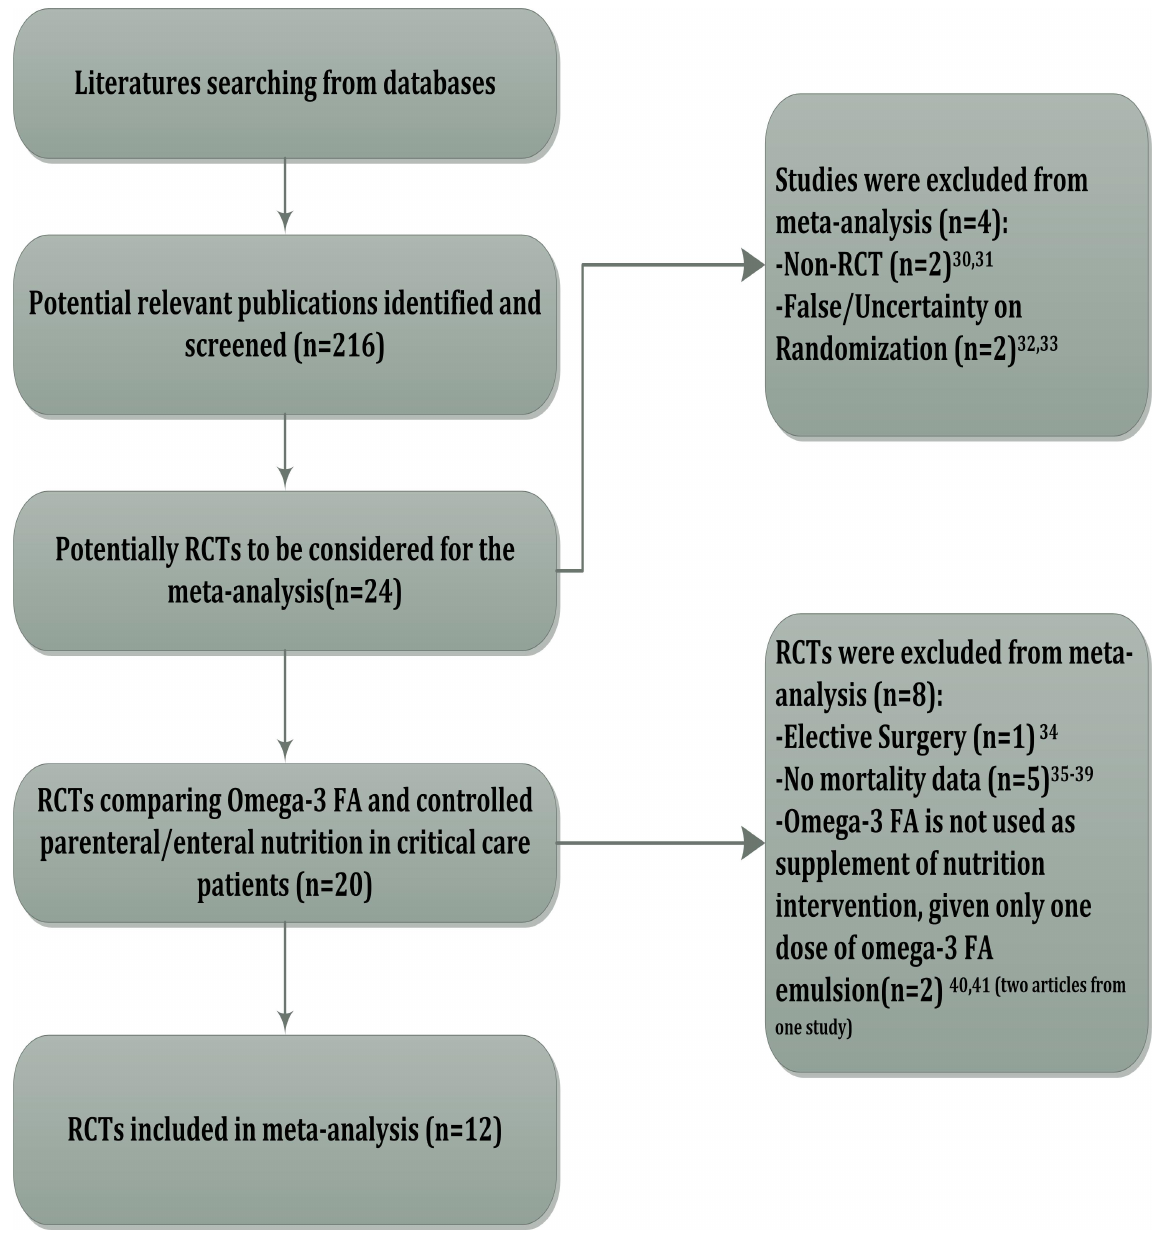
Figure 1. Literature searching and